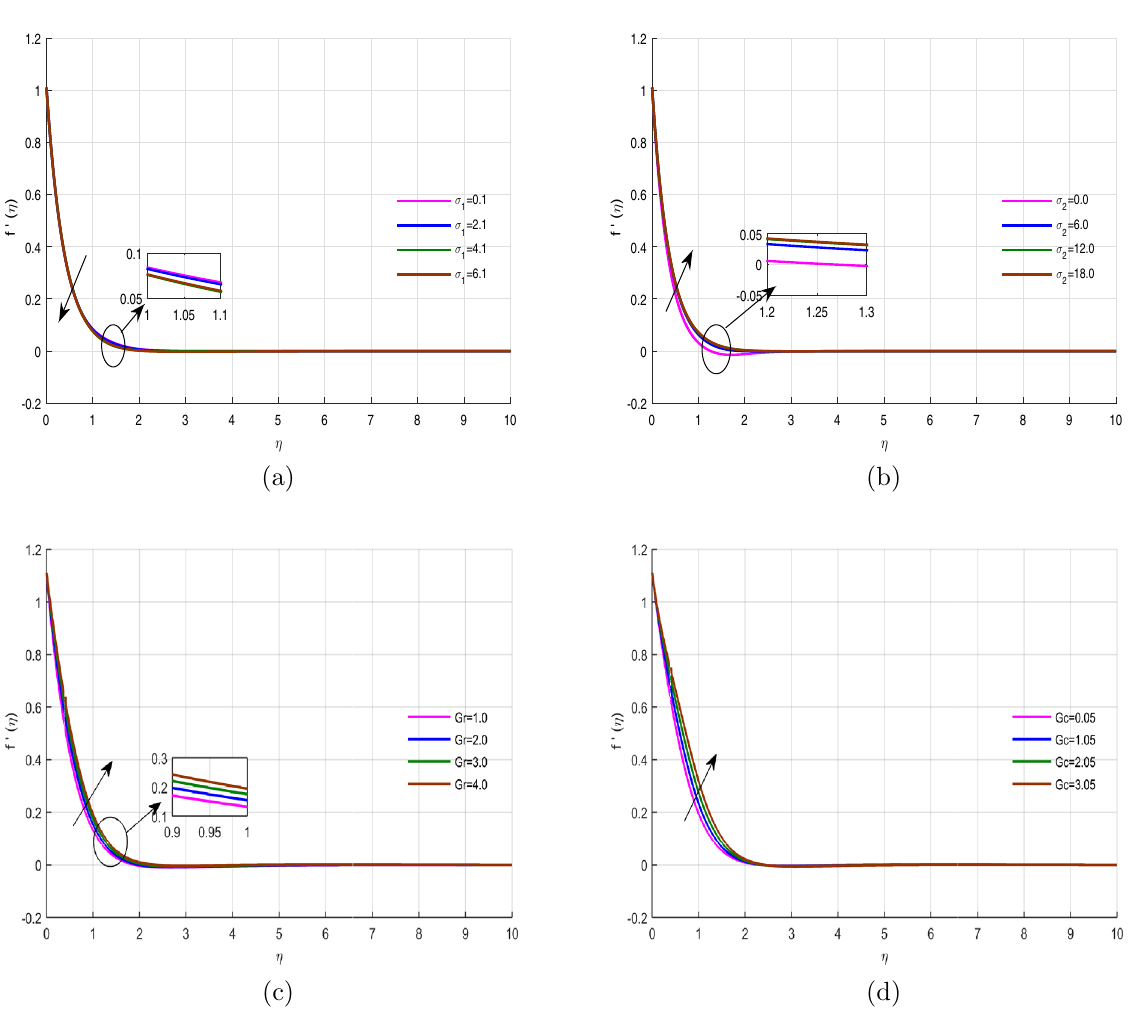
Figure 7. Velocity profile f ′ (η) for fixed values of physical parameters (cid:31) = 0.1 k = 8.933 , Pr = 6.0 , M = 0.5 , Gr = 0.09 , Gc = 0.05 , σ 1 = 1.1 , σ 2 = 10.9 , R = 0.5 , Ec = 0.6 , Nb = 0.01 , Nt = 0.1 Sc = 9.0 , fw = 1.0 , ϕ = 0.2 , n = 0.01 and β = 2.5